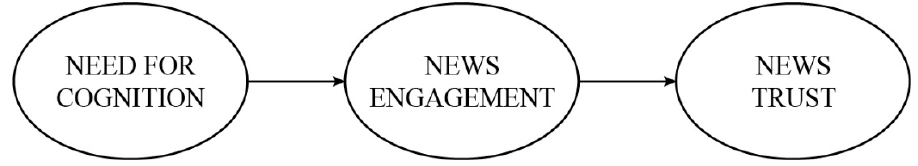
Figure 1. Conceptual framework of the relationship between NFC, news engagement, and news